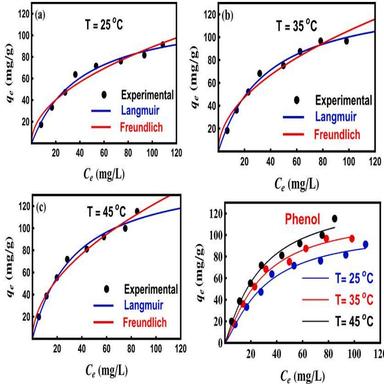
Experimental phenol equilibrium fitting to Langmuir, Freundlich, and monolayer models using nZVI@ACh composite as adsorbent at different temperatures.